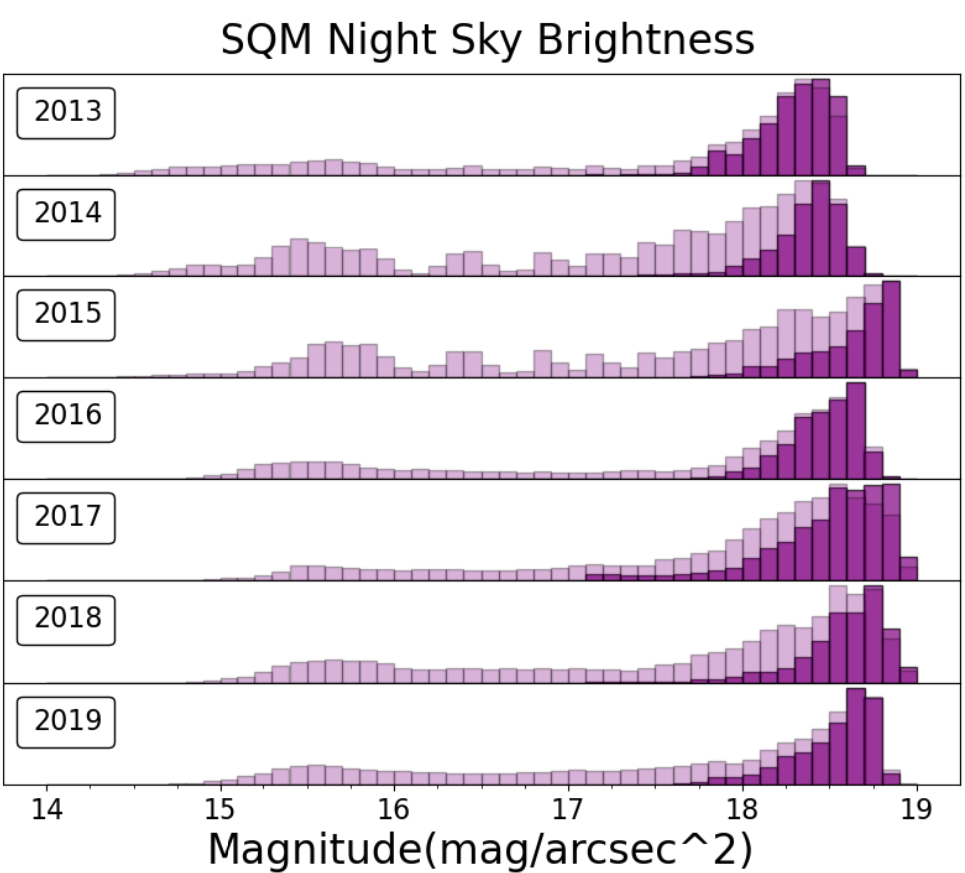
Figure 11. Evolution of SQM magnitudes by grouping the data into years. Darker bars represent filtered data (no moon over the horizon and no clouds), and lighter bars are unfiltered data (with moon and clouds). As expected, the unfiltered data were distributed to the left of the filtered data, indicating brighter skies on nights with moon and/or clouds (similar to Figure 7). All measures excluded twilight.